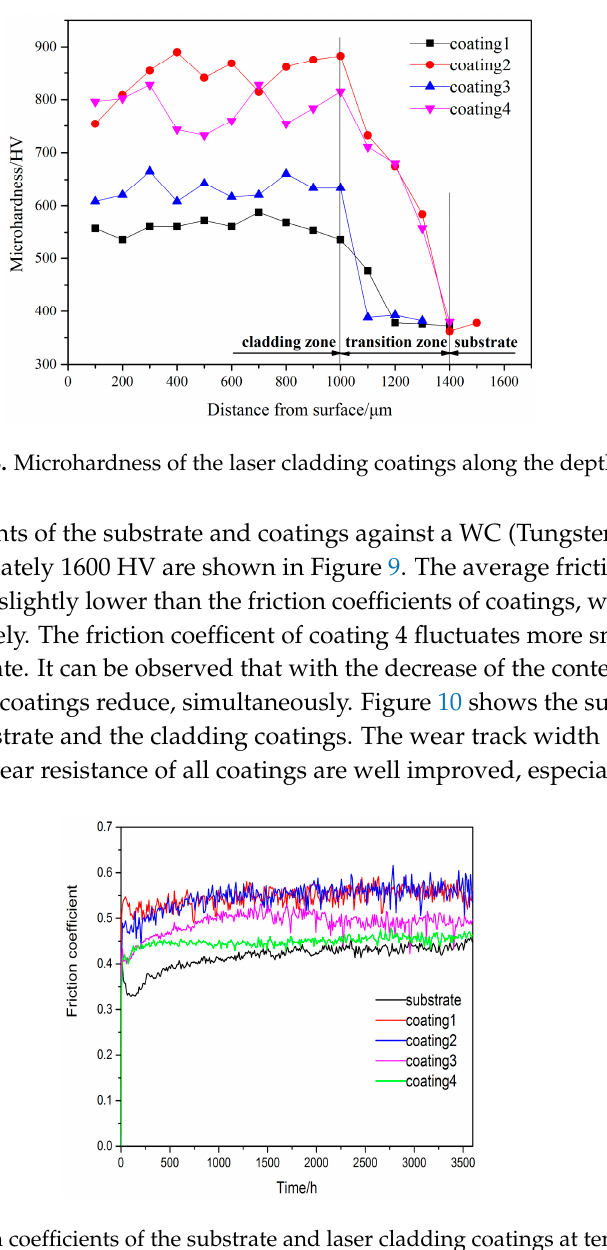
Figure 10. Profiles of the substrate and cladding coatings after friction and wear test.